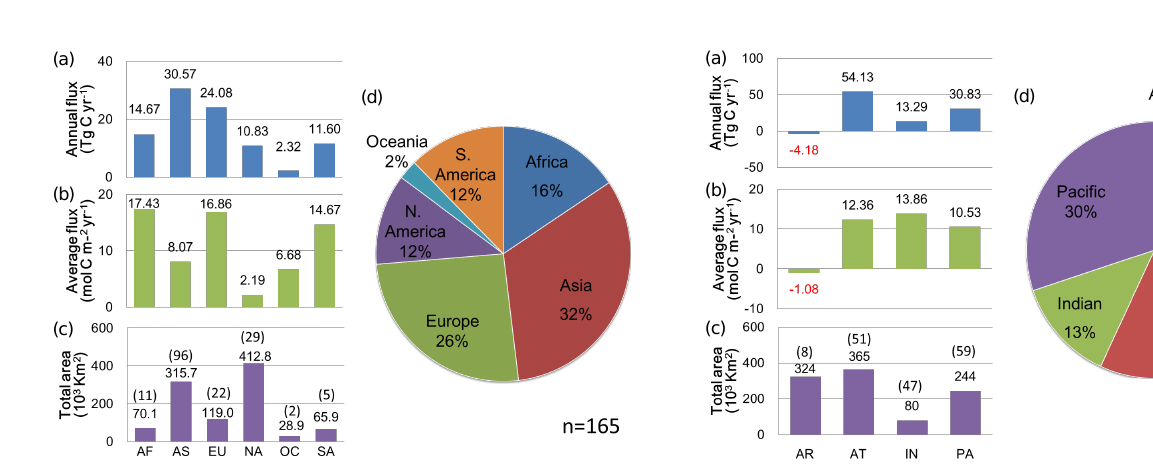
Figure 5. Global wind potential (courtesy Y.Y. Zhou).2 Fig. 5. Global wind potential (courtesy of Y. Y. Zhou).